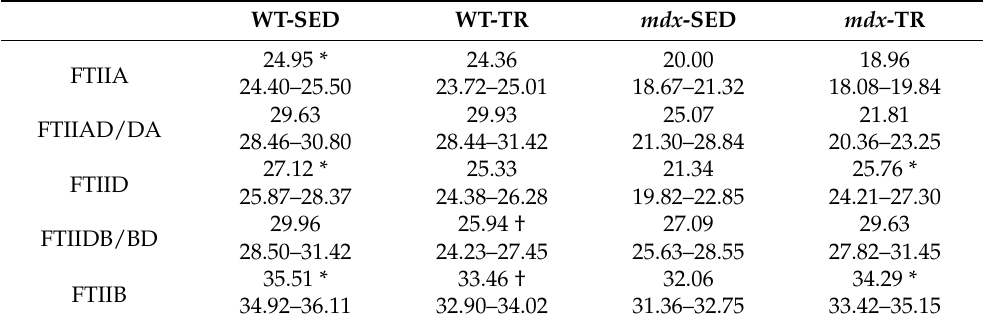
Table 2. Mean values of minimal Feret’s diameters ( µ m) and the respective 95% confidence intervals (bottom rows) in psoas type IIA, type IIAD/DA, type IID, type IIDB/BD, and type IIB fibers in the different groups